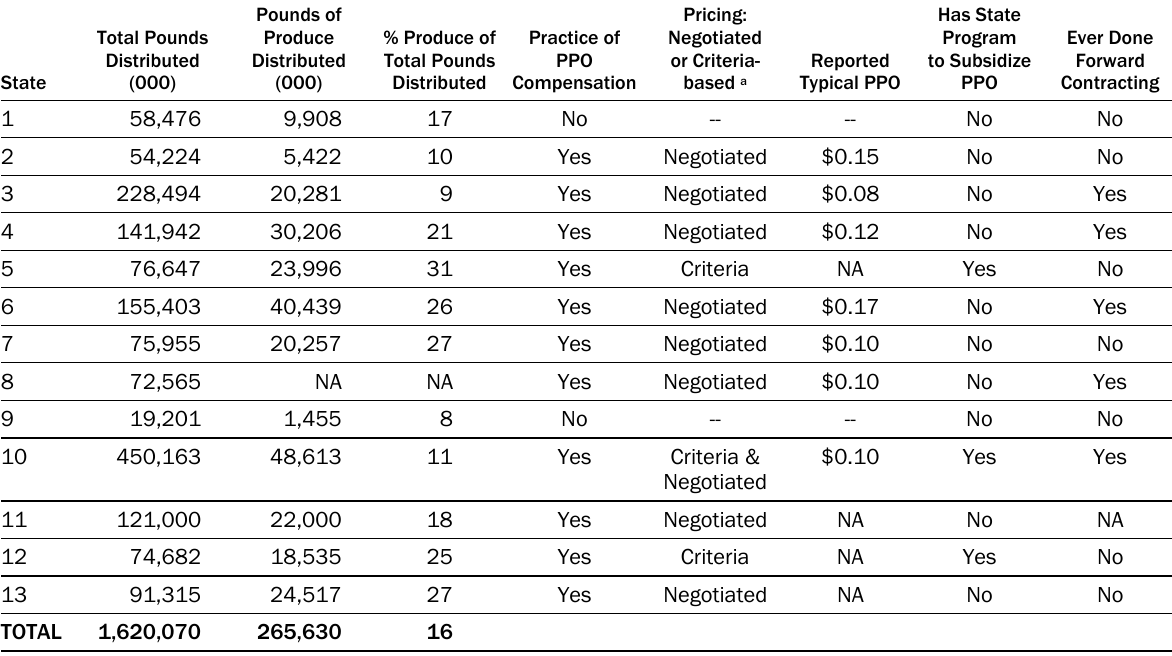
Table 2. Summary of Findings from Interviews with Food Banks in 13 Southern U.S. States, Including Pick and Pack-out Cost (PPO) Compensation from Food Banks to Growers